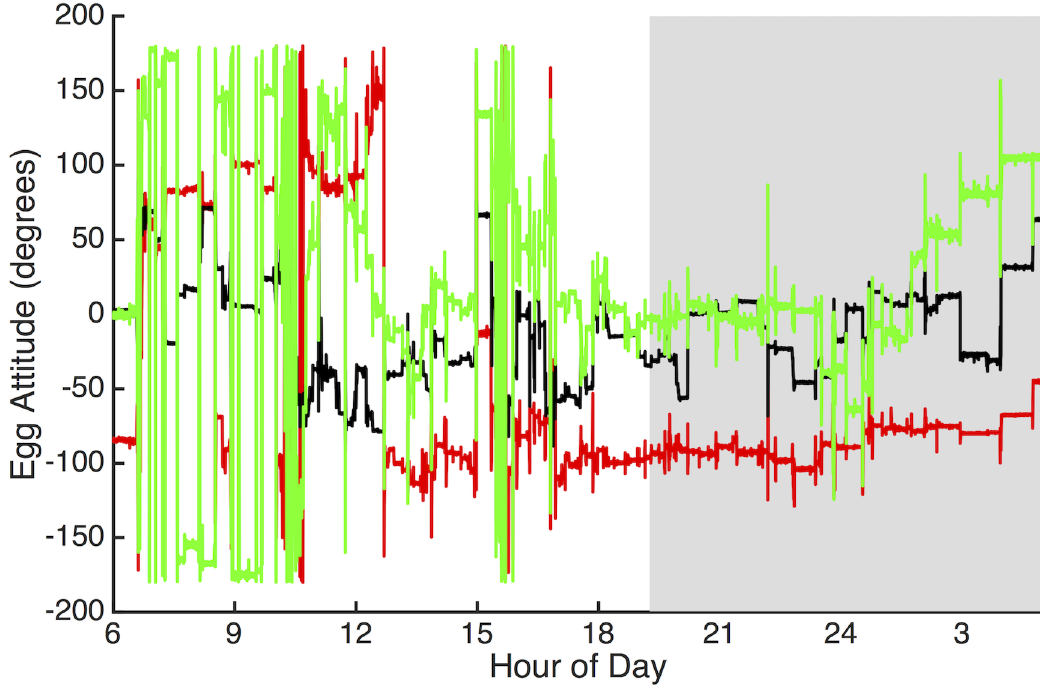
Fig 1. The three aspects of egg orientation (roll, pitch, and yaw) in a single Forster’s tern egg. White areas indicate daytime, while gray areas indicate nighttime. The red line represents roll, the black line indicates pitch, and the green line indicates yaw. Note the large change in yaw angle relative to roll and pitch, as well as the difference in egg turning activity between night and